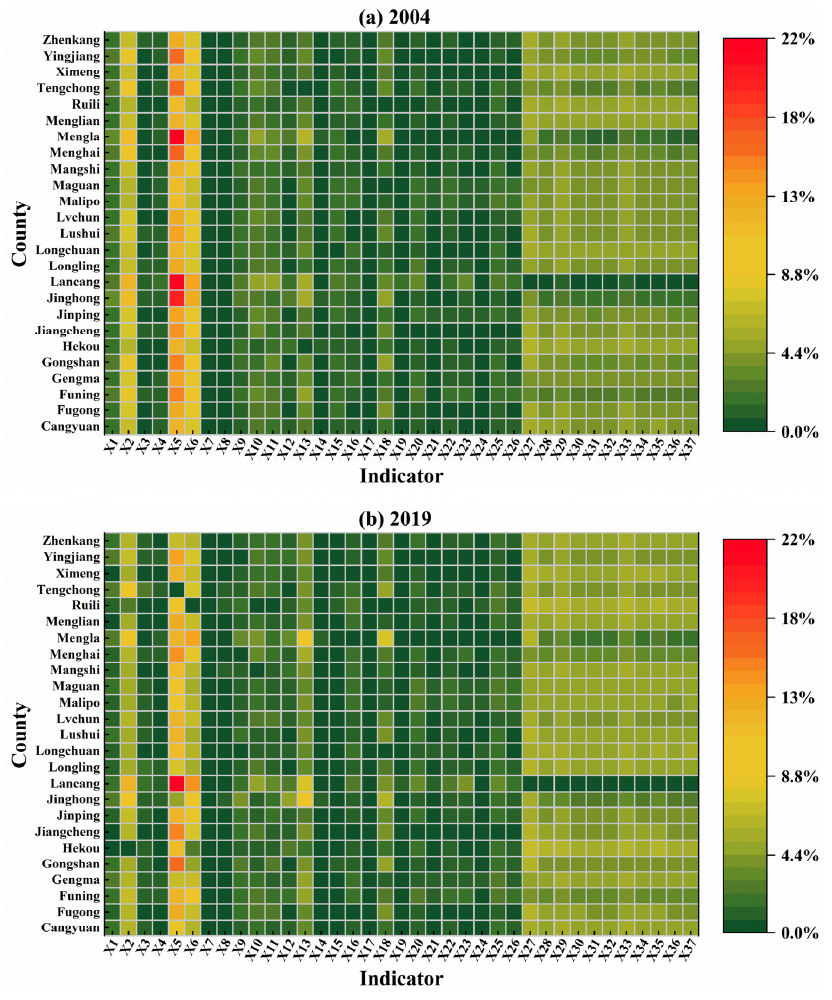
Figure 6. The obstacle degree of each indicator of ecological security in 25 border counties in Yunnan Province, China in: ( a ) 2004 and ( b ) 2019 (%).